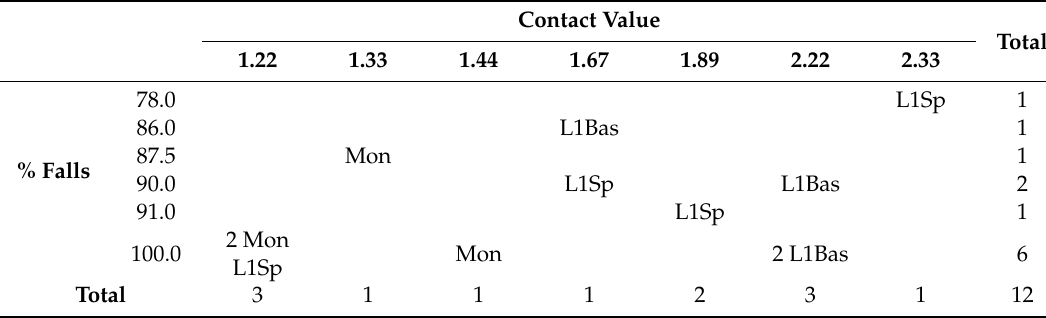
Table 8. Percentage of interrogative sentences ending in falling contours according to degree of contact and speakers’ language profile.